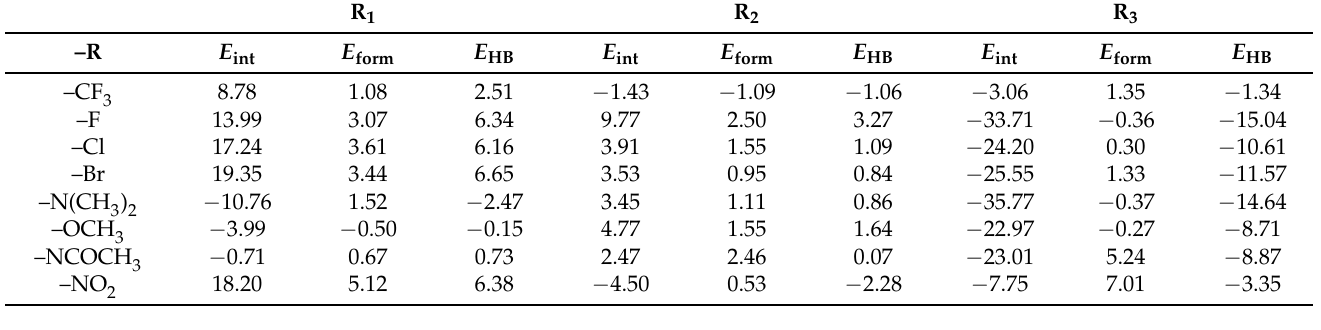
Table 2. IQA interaction energies ( E int ), formation energies ( E form ) computed by means of the OCM (expression (3)), and H-bond interaction energies ( E HB ) estimated via Equation (4) for the investigated O ··· H RAHB contacts. The values are reported in kcal · mol − 1 . R 1 R 2 R 3